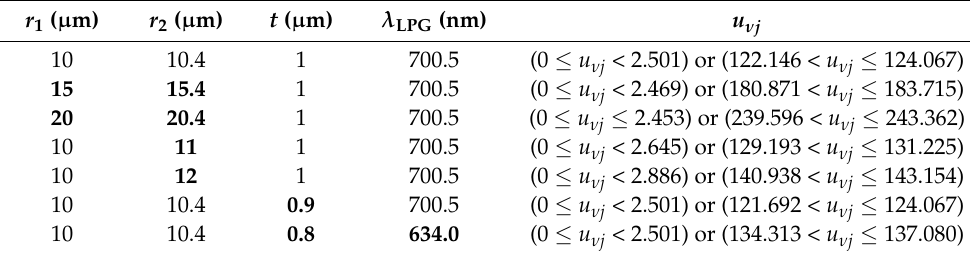
Table 3. Solutions of inequality (16) ( u ν j ) for different NCHCF and LPG parameters. The values in bold are changed in comparison to the parameters of the initial NCHCF and LPG, which are presented in the first row of the table. In the case of t = 0.8 µ m, the λ LPG has also been changed to match the shifted first-order antiresonant bands of both NCHCFs. The antiresonance order and grating wavelength order assumed for the calculations are m = 1 and N = 1,